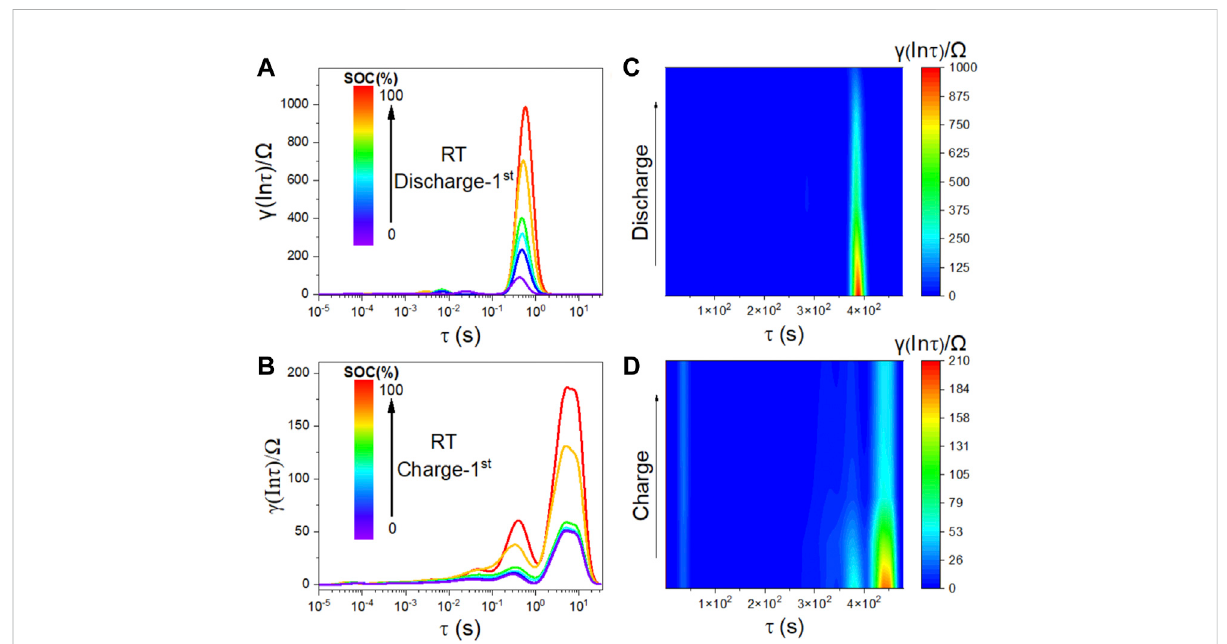
The (A,B) DRT curves and (C,D) obtained based on the in situ EIS of the assembled FeS 2 /Li 7 P 3 S 11 /Li-In battery when cycled at 0.1C between 0.6 and 2.4 V (vs. Li-In) under room